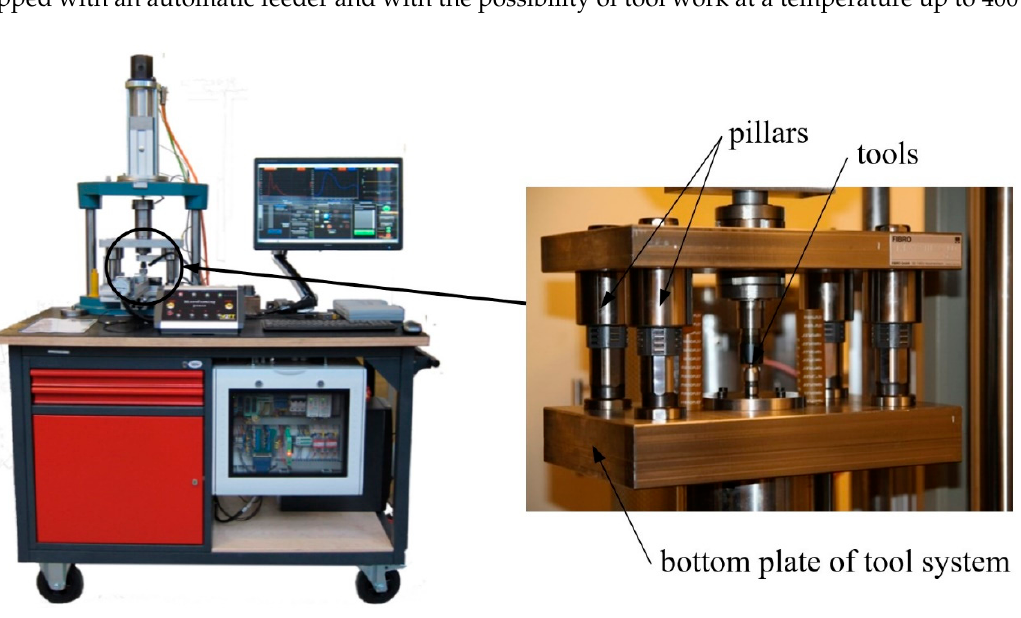
Figure 3. Machine for microforming processes.